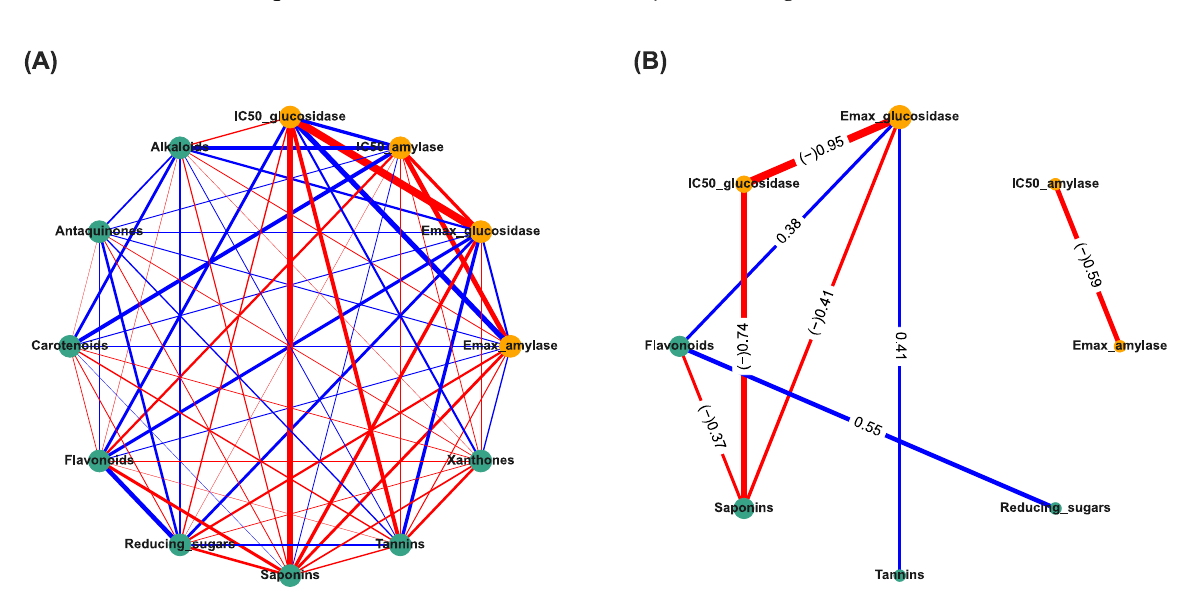
Figure 2. Correlation-based network analysis between α -amylase and α -glucosidase inhibitory activities and phytochemical components of 31 TTM plants samples. ( A ) Spearman’s correlation analysis between α -amylase and α -glucosidase inhibitory activities (i.e., E max and IC 50 against α -amylase and α -glucosidase enzymes) and eight phytochemical constituents found in 31 TTM samples. ( B ) Significance Spearman’s correlation between the α -amylase and α -glucosidase inhibitory activities and phytochemical compounds of 31 medicinal Thai herb samples ( p < 0.05). The IC 50 was categorized as active: 1 (IC 50 can be calculated), and inactive: 0 (IC 50 cannot be calculated). Each green node and orange node determines the phytocomponents, and bioactivities of the TTM, respectively. The respective positive (+) and negative ( − ) correlations ( r ) are presented in light-blue and red edges (connection line between two nodes). The thickness of each edge represents Spearman’s correlation coefficient ( r ).